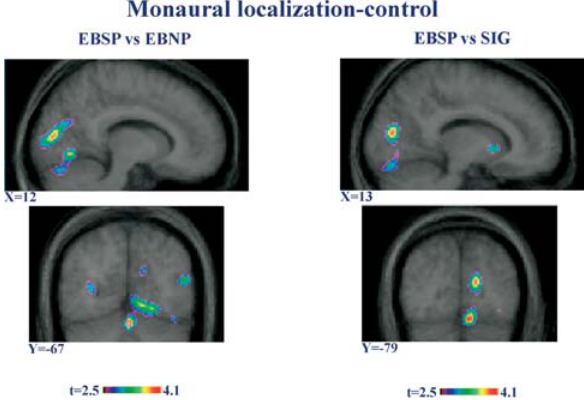
Figure 4. Intergroup Contrasts in Monaural Sound Localization Minus Control Task Sagittal (top) and coronal (bottom) images showing contrasts between the EBSP and EBNP (left), and between the EBSP and SIG (right). These contrasts confirmed the differences in occipital areas between the EBSP group and the two other groups. X and Y coordinates refer to standardized stereotaxic space. DOI: 10.1371/journal.pbio.0030027.g004